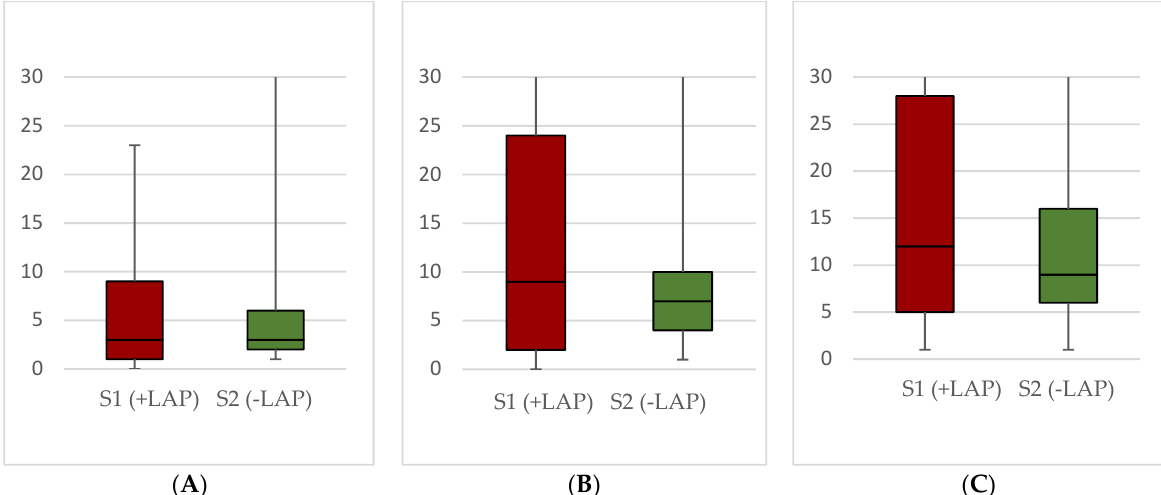
Figure A2. Study population. S1—Standard 1 with LAP, S2—Standard 2 without LAP.